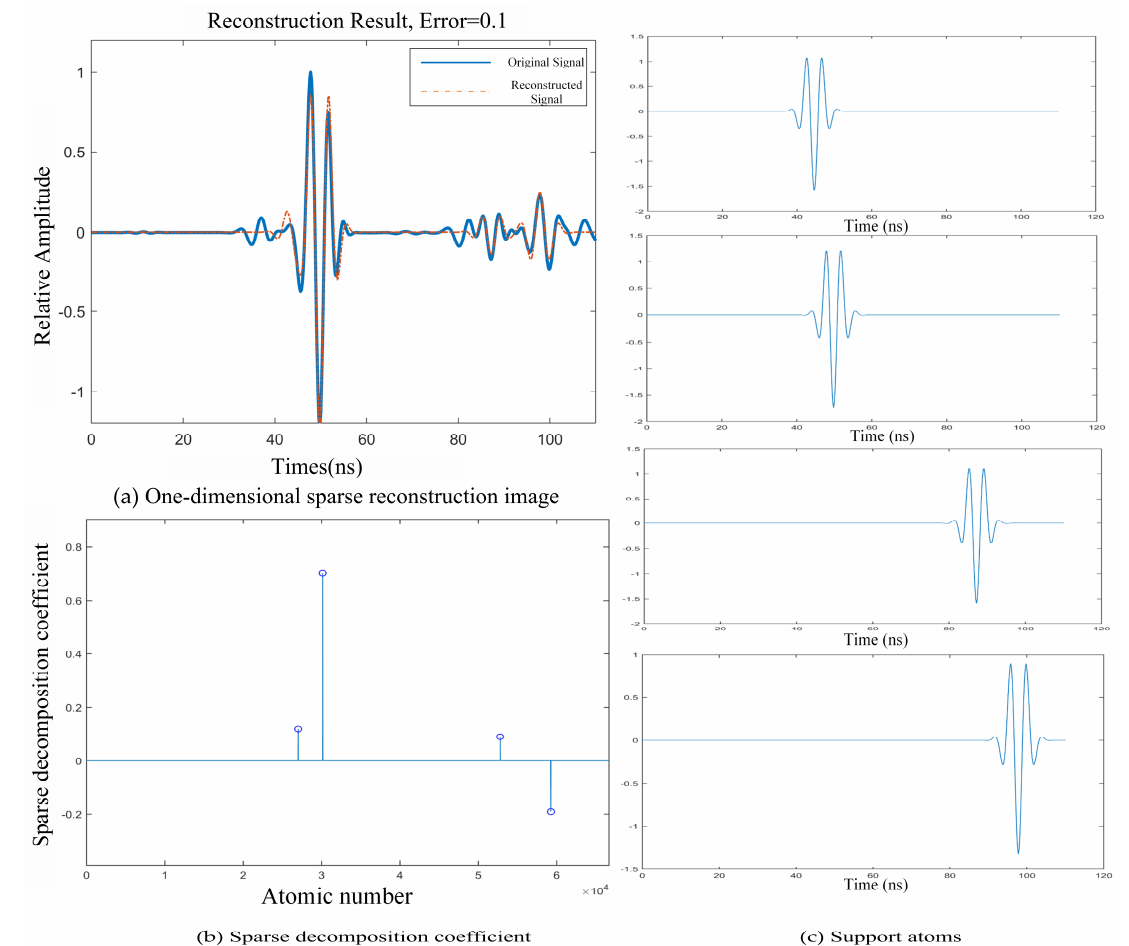
Figure 10. Time domain signal and supporting set atoms of one-dimensional sparse reconstruction, threshold of 0.1.